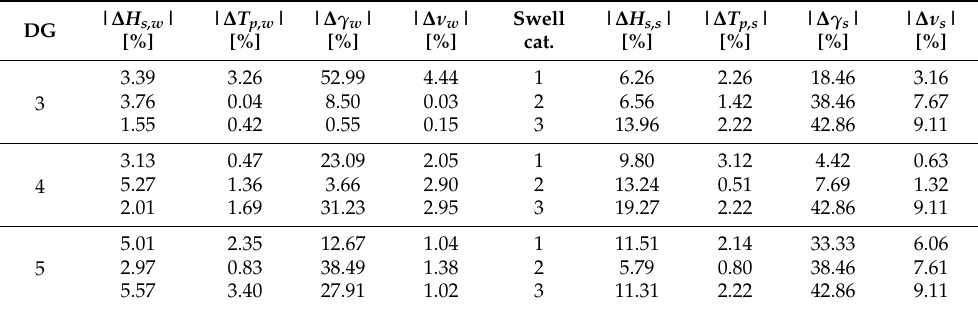
Table 7. Sea state assessment (Welch)—short duration and low frequency.